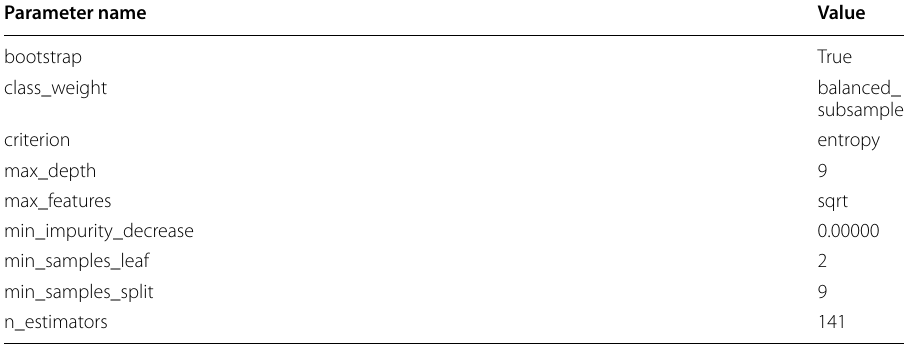
Table 101 Modes of RF tuned hyperparameter values for experiments with the keylogging dataset